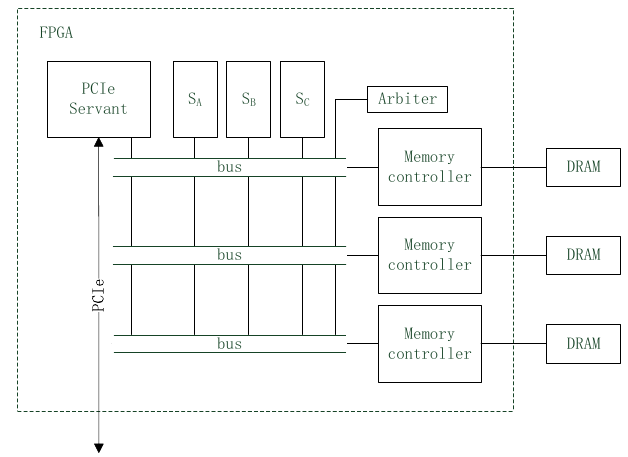
Figure 8. Post-style communication architecture.